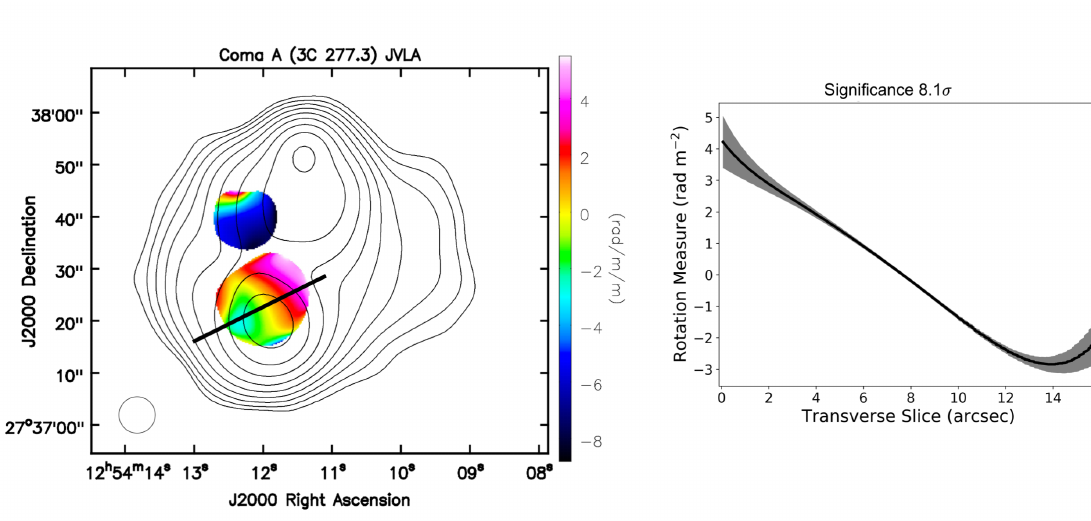
Figure 1. Left panel shows a Faraday rotation image made using a wideband JVLA observation from 1–2 GHz, the beam is shown by the circle in the lower left corner of the image. The Stokes I contours correspond to the 1.5 GHz and start at 1 mJy and increase in factors of 2. The data for 16 frequencies in this range were fitted using the CASA rmfit task. Right panel shows the slice taken of the rotation measure (RM) along the path taken by the black line in the right panel. The gray shading is the 1 σ error in the RM for each